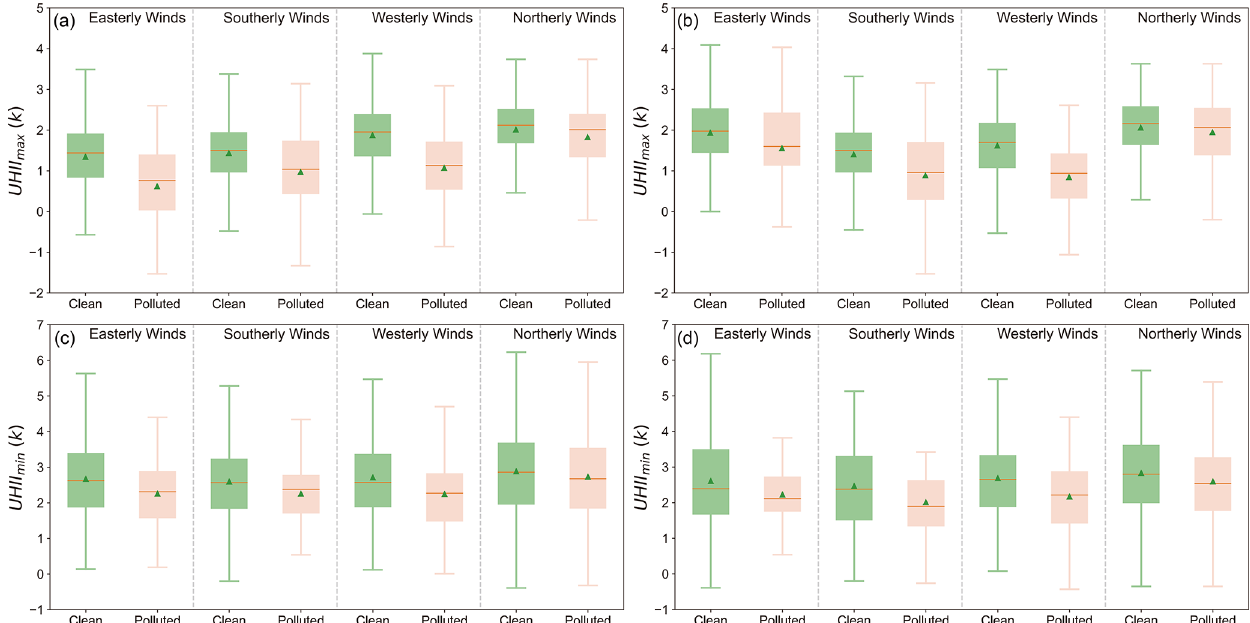
Figure 3. Distribution of UHII under different wind and pollution conditions, (a) and (c) are classified based on the wind direction in urban areas, while (b) and (d) are based on wind direction in rural areas. Green triangles represent average values, red lines are median values, box chart values denote mean values minus standard deviation, 25% quantile, 75% quantile, and the mean value plus standard deviation from bottom to top,